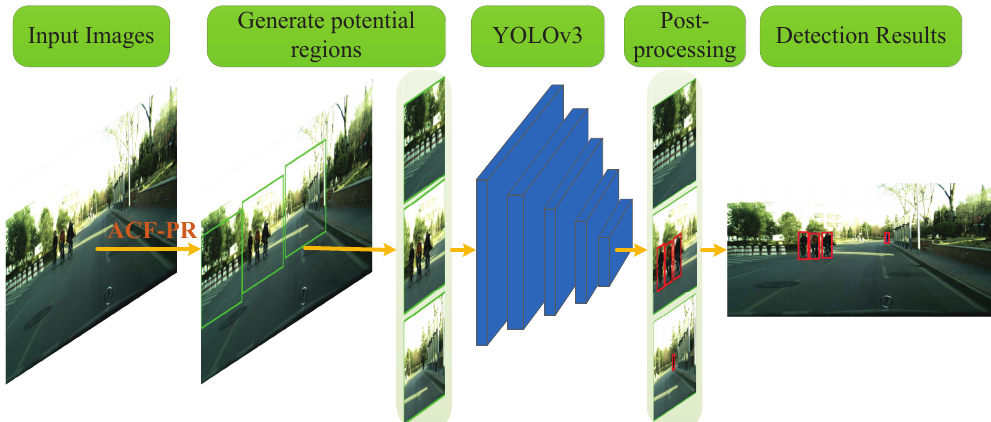
Figure 1. Overview of the proposed cyclist detection method. Color images are first processed by the aggregated channel feature region proposal (ACF-PR) method. The proposed ACF-PR method utilizes ACF to get region candidates, and then it performs the analysis of these candidates to generate potential regions. Then the YOLO network utilizes these potential regions as inputs to do fine detection and localization. At last, to get the final result, a post-processing step is performed to merge and map the bounding